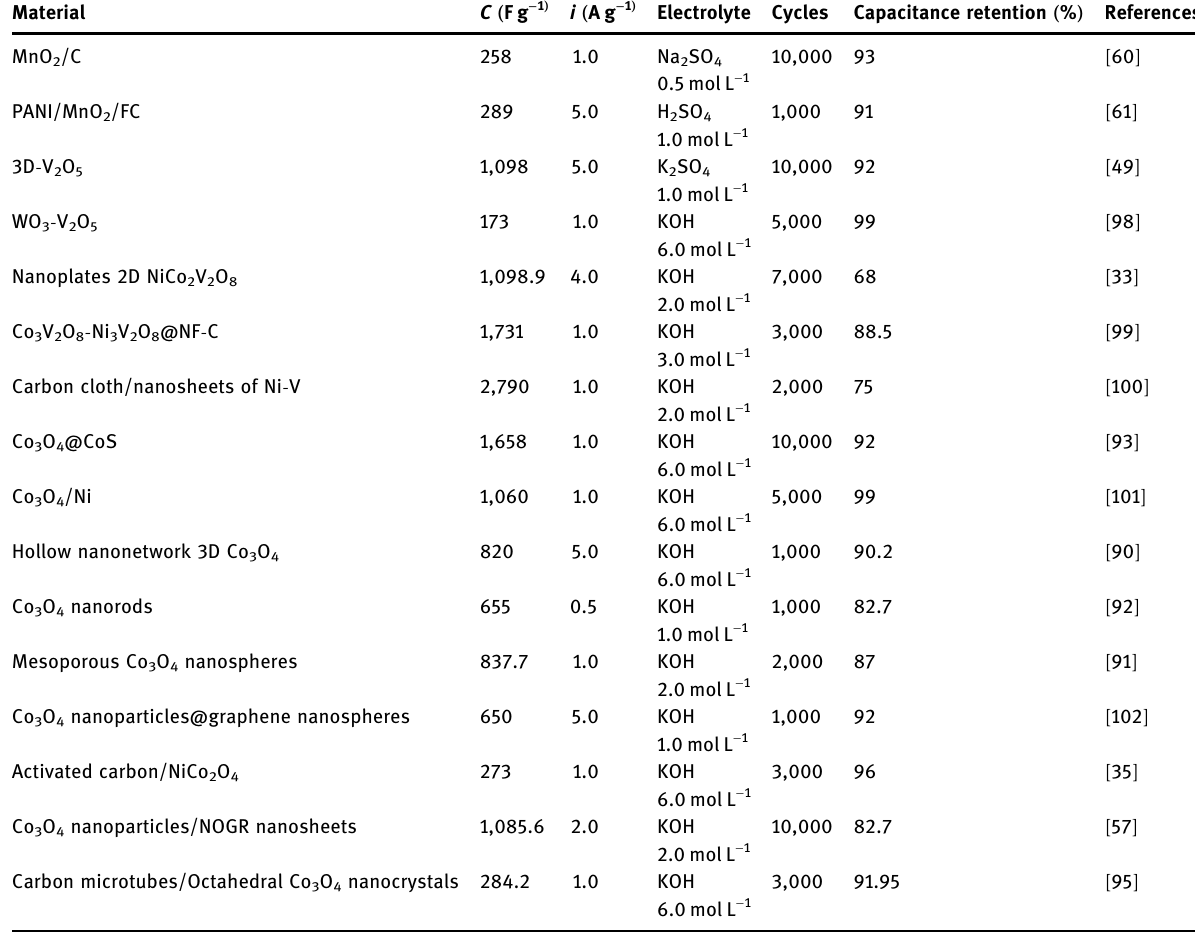
Table 1: Some transition metal oxides and their electrochemical parameters for application in supercapacitors